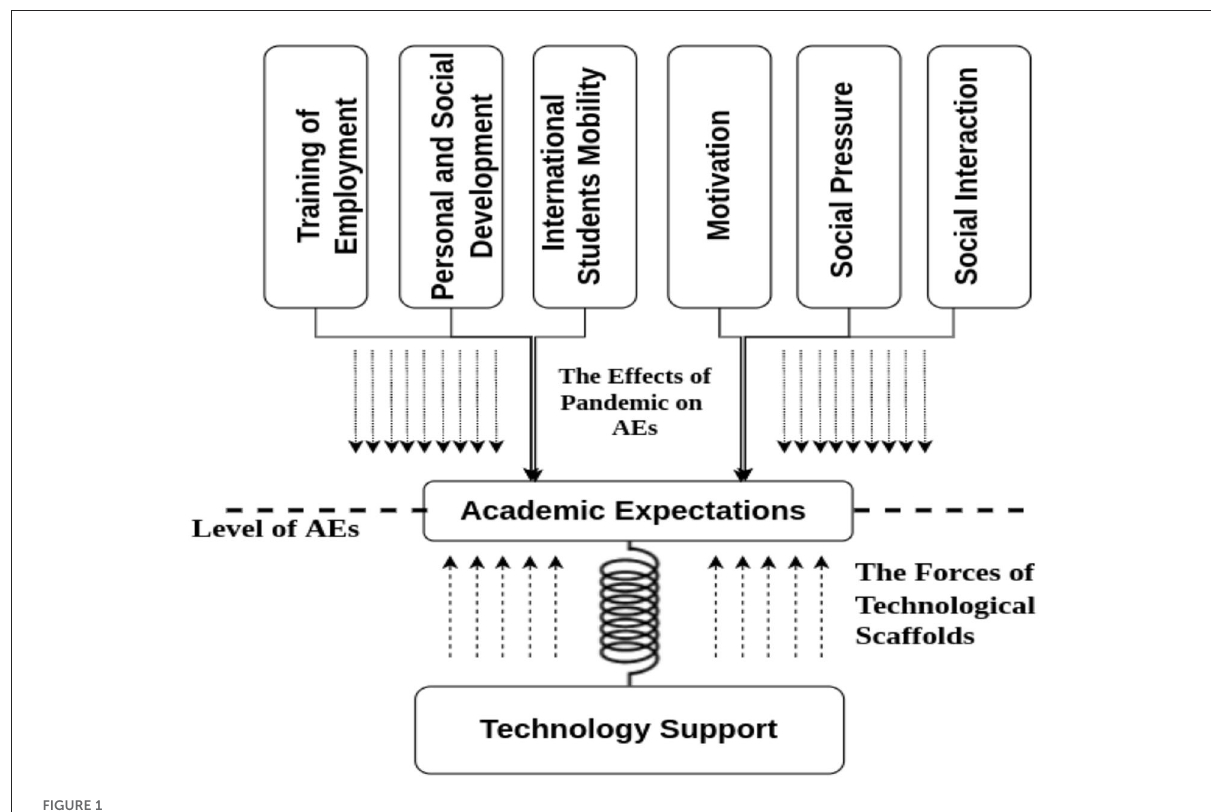
FIGURE1 Conceptual